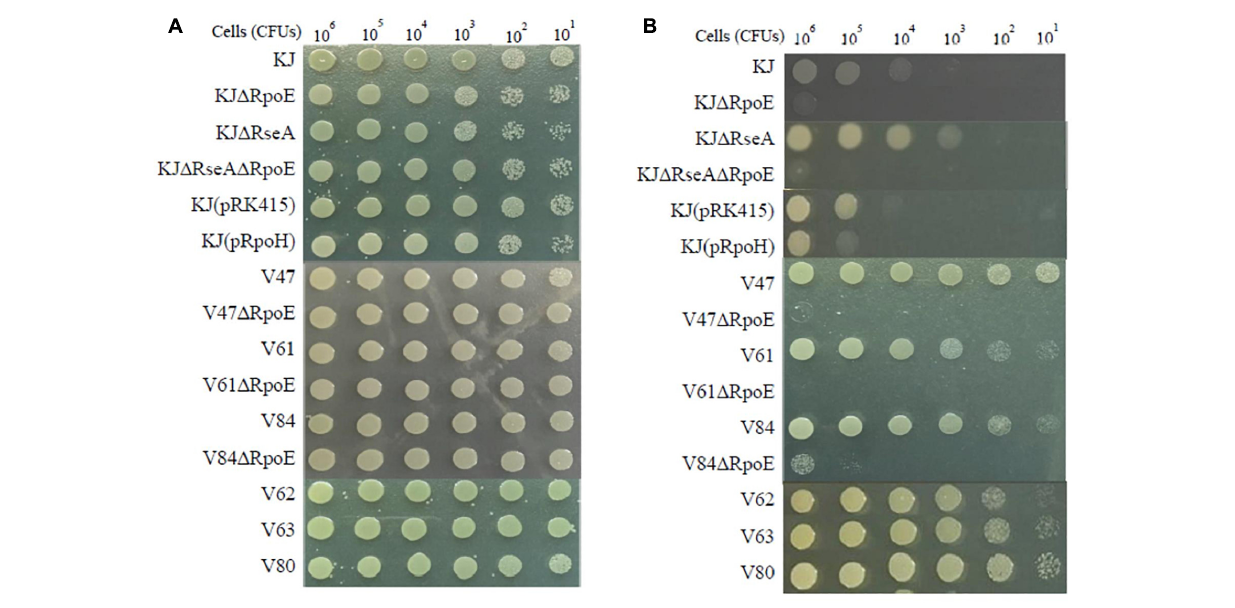
FIGURE 1 | Viability of S. maltophilia isolates and their derived mutants after heat shock. The logarithmic-phase bacterial cells were collected, adjusted to 2 × 10 5 CFUs/ µ l, and 10-fold serially diluted. Then 5 µ l of the bacterial cells were spotted on LB agar. After an 18-h incubation period, bacterial cell growth was observed. (A) Incubation at 37 ◦ C. (B) Incubation at 40 ◦